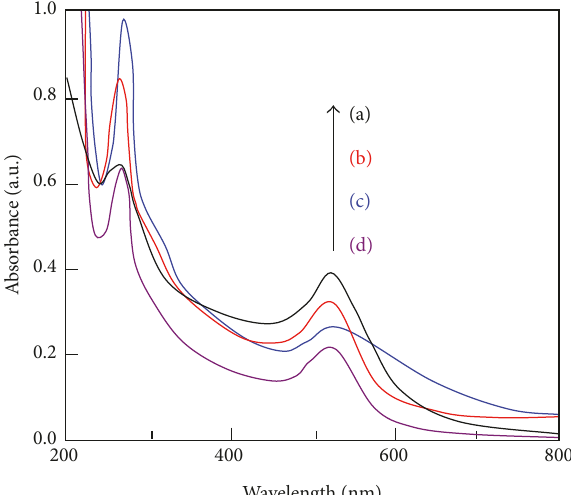
Figure 8: UV-Vis spectra of original AuNPs/dextran solution (a), and AuNPs/dextran solutions from AuNPs/dextran powders: spray drying (b), centrifugation (c), and coagulation (d).